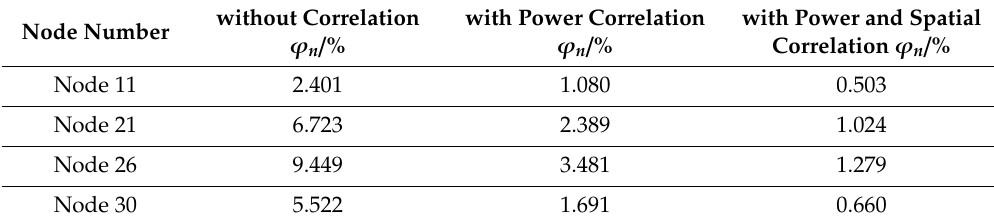
Table 6. Deviation estimation indicators with / without correlation.